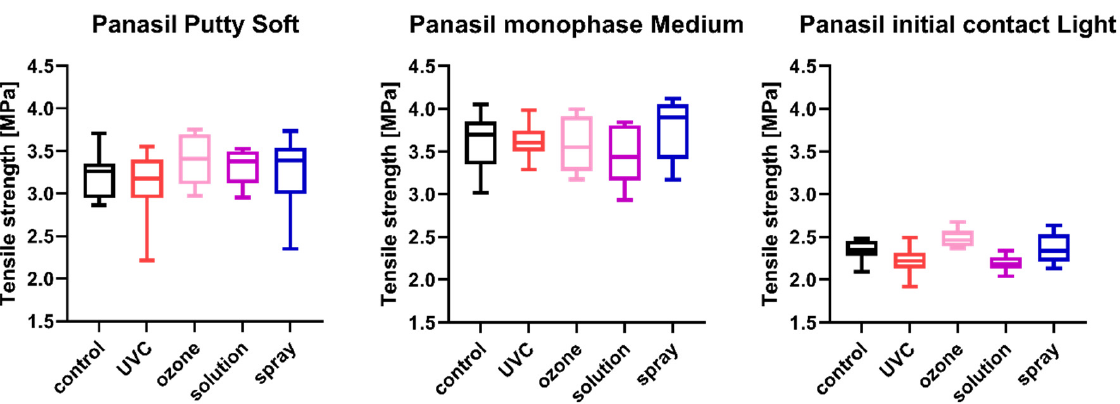
Figure 4. Tensile strength of A-silicones (Panasil Putty Soft, Panasil monophase Medium, and Panasil initial contact Light) after disinfection using various methods.